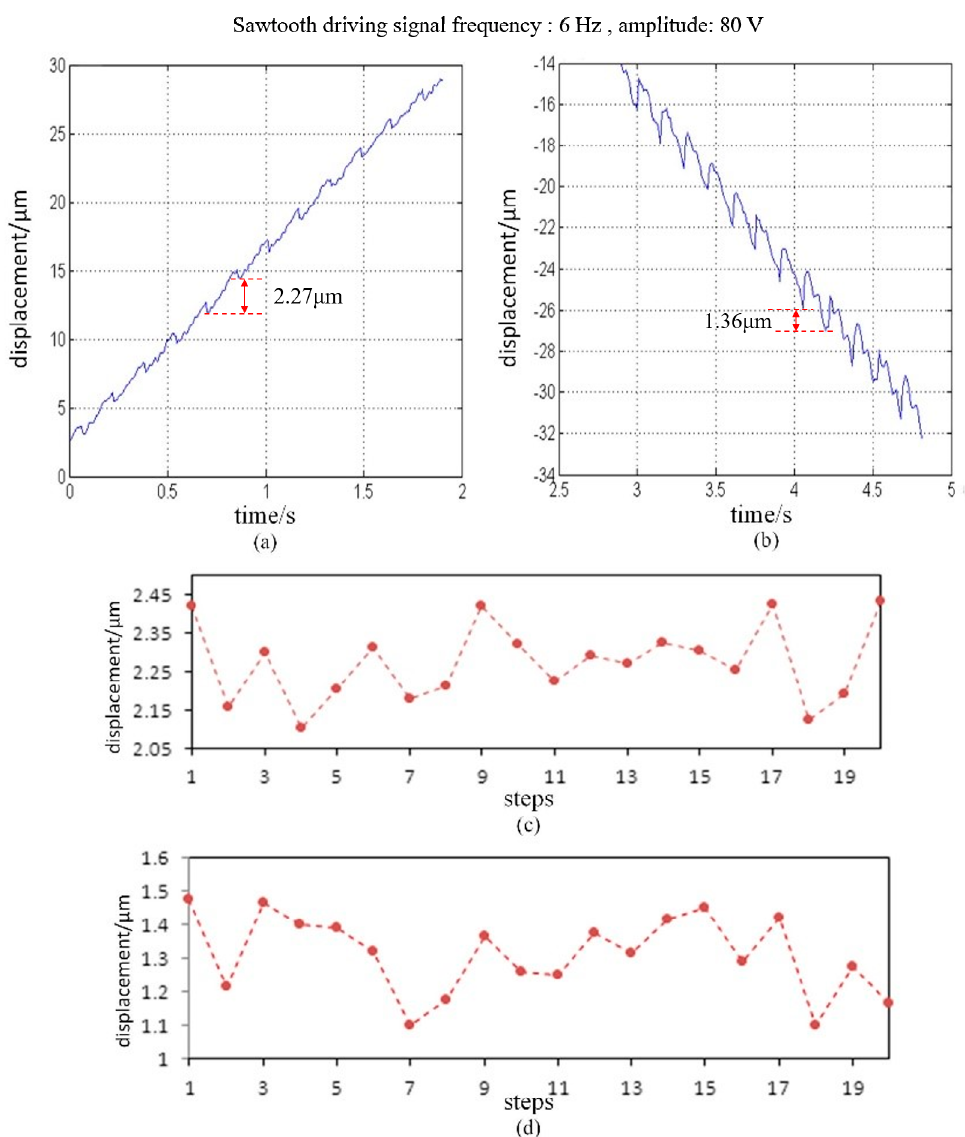
Figure 11. Forward and backward movement of the PASNS under a conventional sawtooth driving signal: ( a ) forward movement; ( b ) backward movement; ( c ) 20 continuous forward step displacements; and ( d ) 20 continuous backward step displacements.